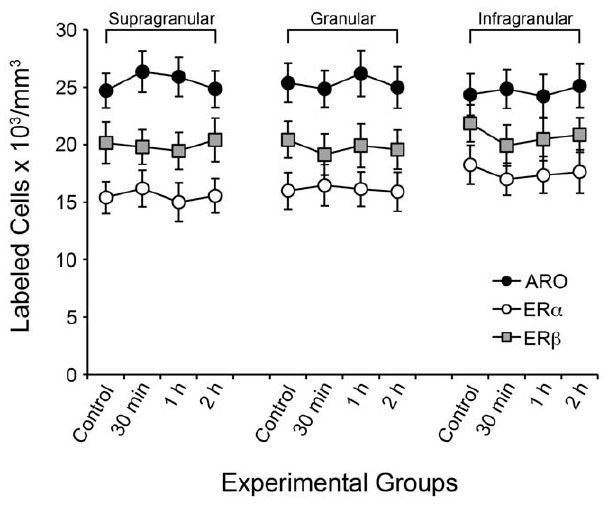
Figure 6. The numerical densities of ARO, ER a or ERß-positive neurons in V1 are not affected by acute visual stimulation. Line graphs depicting the mean ( 6 S.E.) numerical densities of ARO-, ER a and ER b -positive cells in the V1 of unstimulated (control) adult mice, as well as in animals subjected to 30 min, 1 h or 2 h of ambient light stimulation (see Methods). Data is shown for supragranular (II/III), granular (IV) and infragranular (V/VI) layers of the V1 separately. No significant differences were detected for any of the layers and